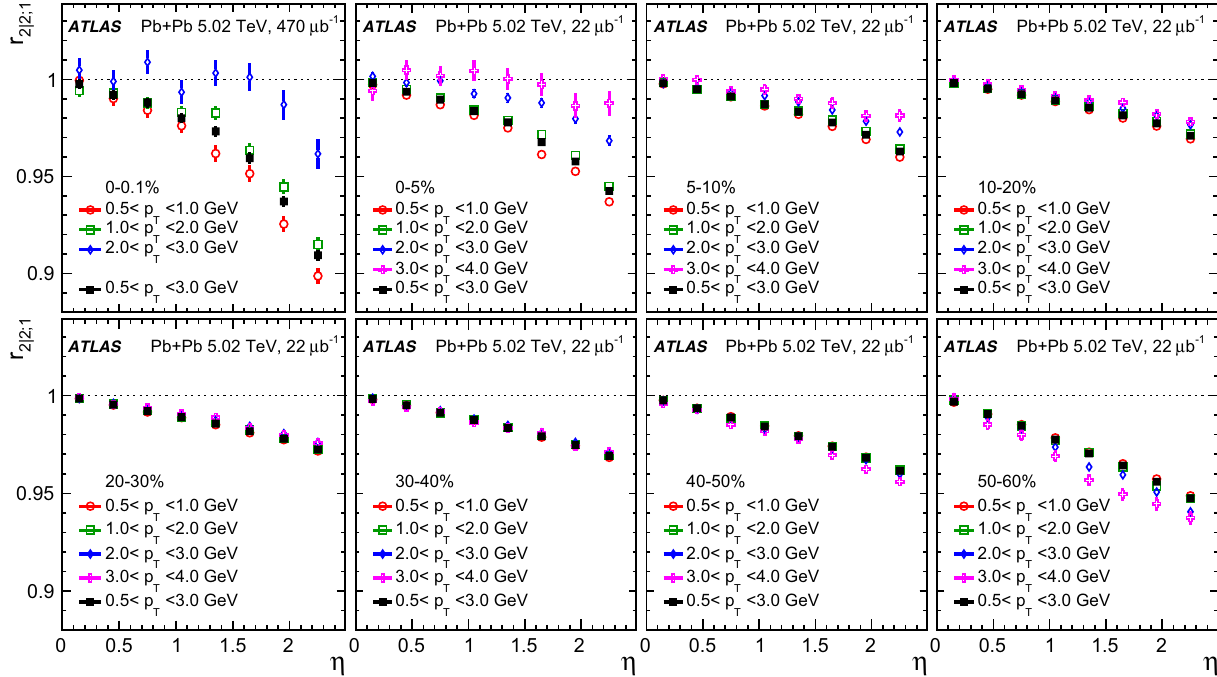
Fig. 3 The r 3 | 3 ; 1 (η) measured for several η ref ranges. Each panel shows the results for one centrality range. The error bars are statistical only